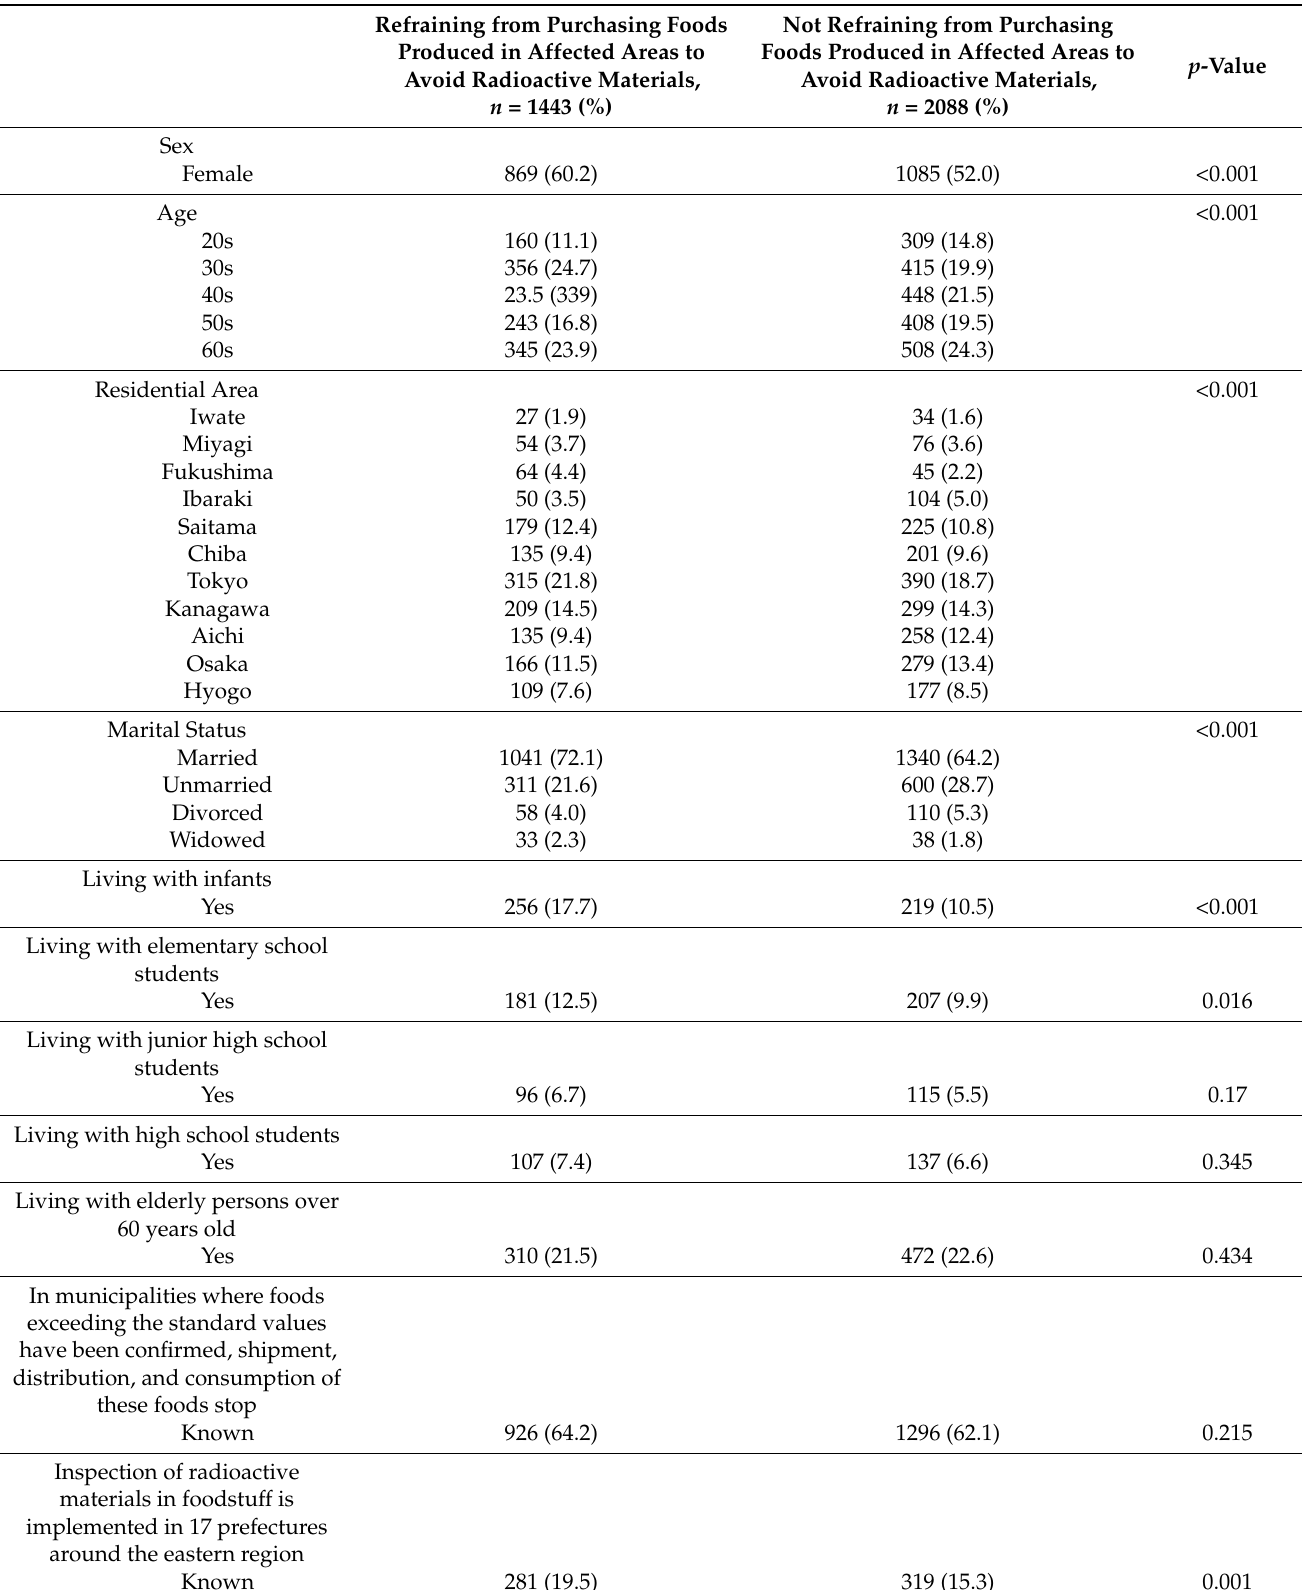
Table 1. Comparison between refraining from purchasing foods produced in affected areas to avoid radioactive materials or not in the first